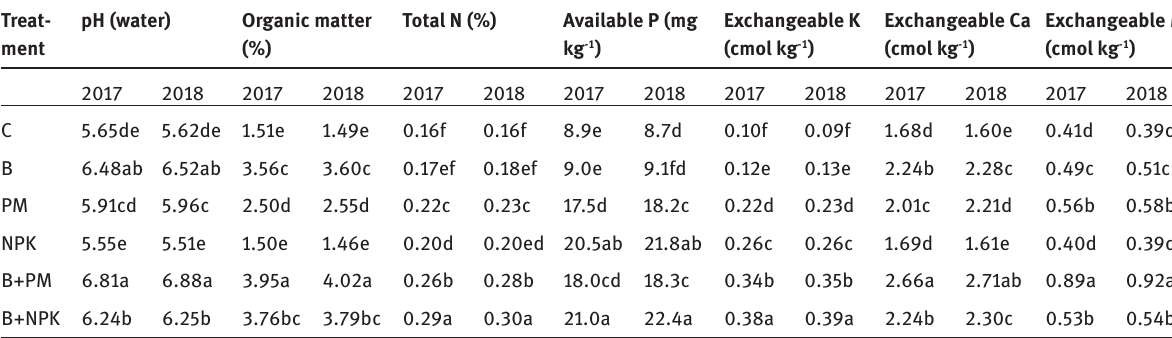
Table 4: Effect of biochar, poultry manure and NPK 15-15-15 fertilizer on soil chemical properties